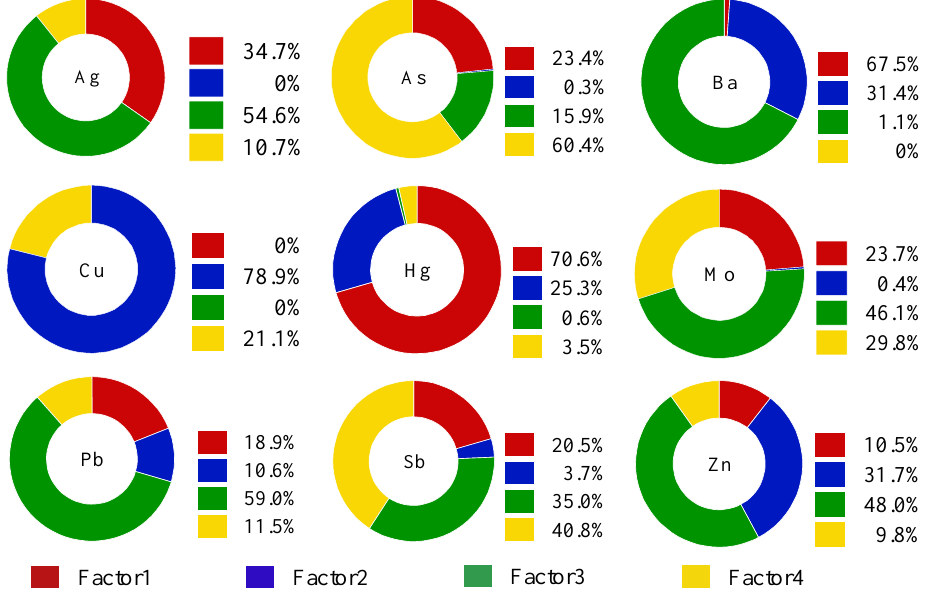
Figure 6. Contribution rate of each factor to potential toxic element concentration distribution.